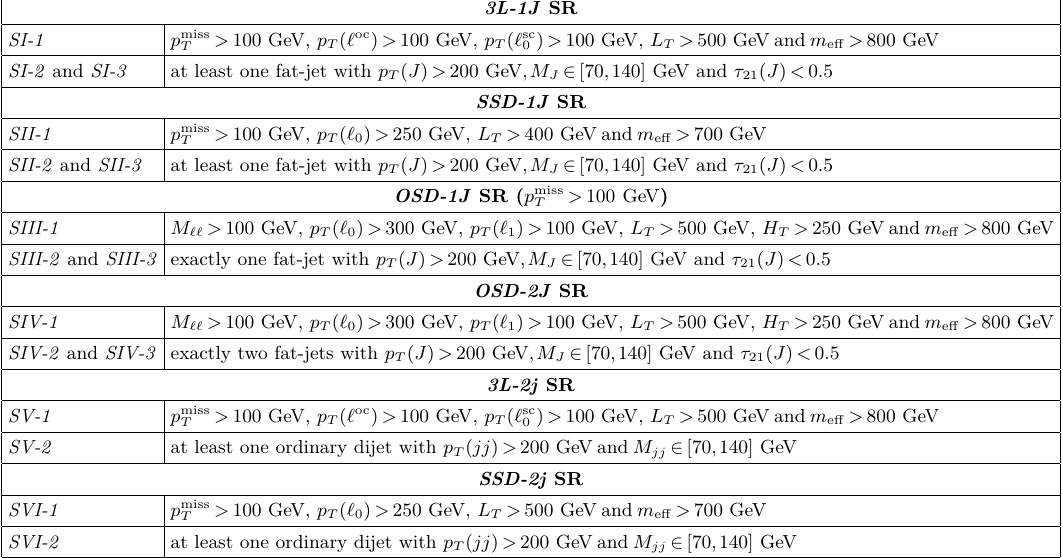
Table 6 . Summary of the SR-specific selection cuts. The OSD-1J and OSD-2J SRs become mutually exclusive after all the selection cuts are